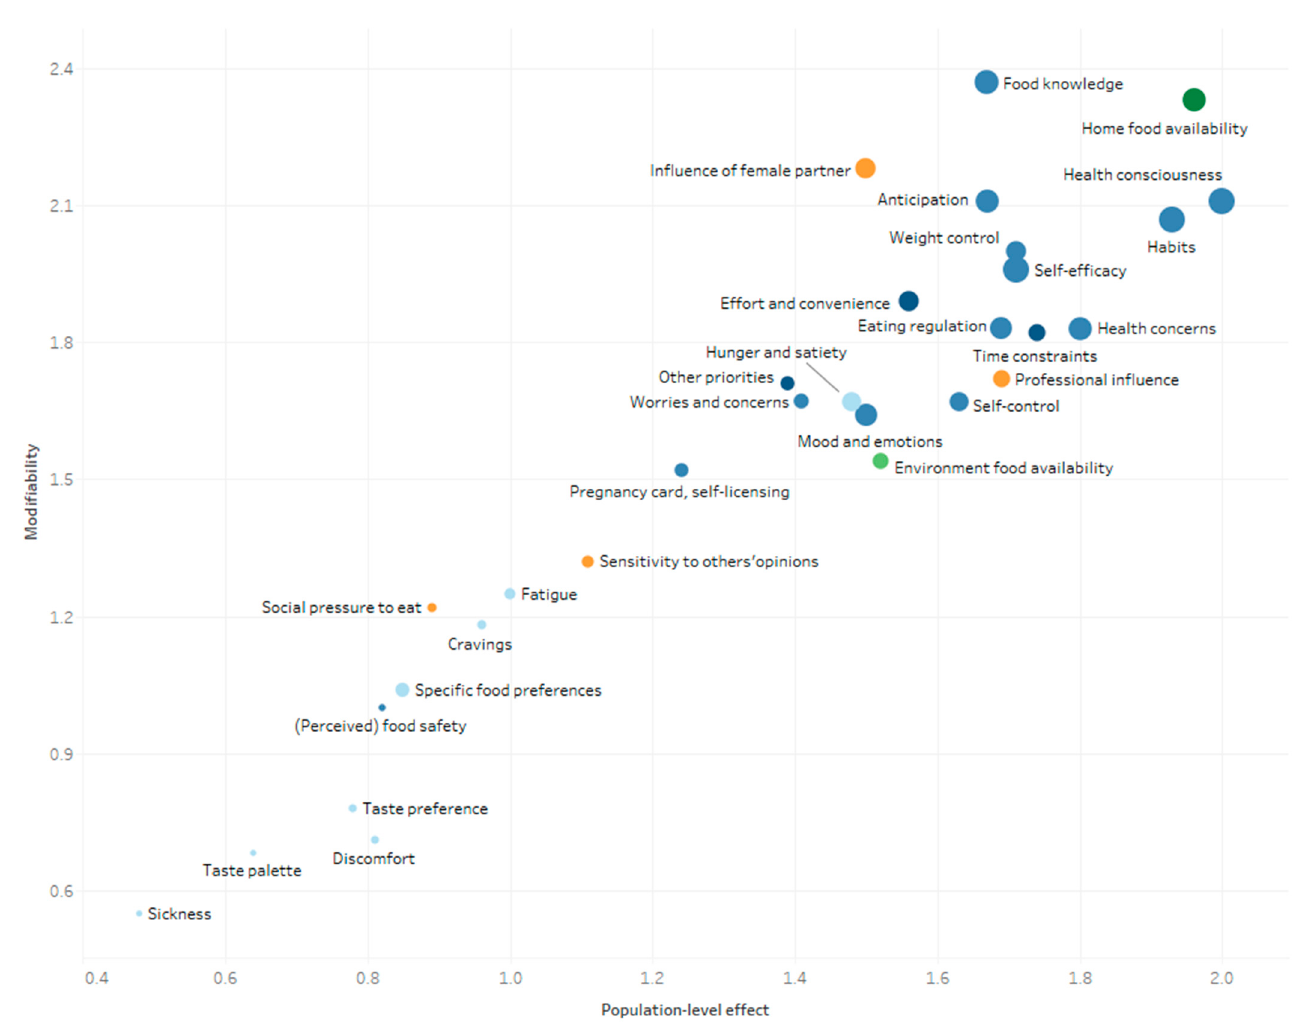
Figure 5. Expert ratings on modifiability, relationship strength, and population-level effect of men’s determinants of changes in eating behavior during the pregnancy of their partner.